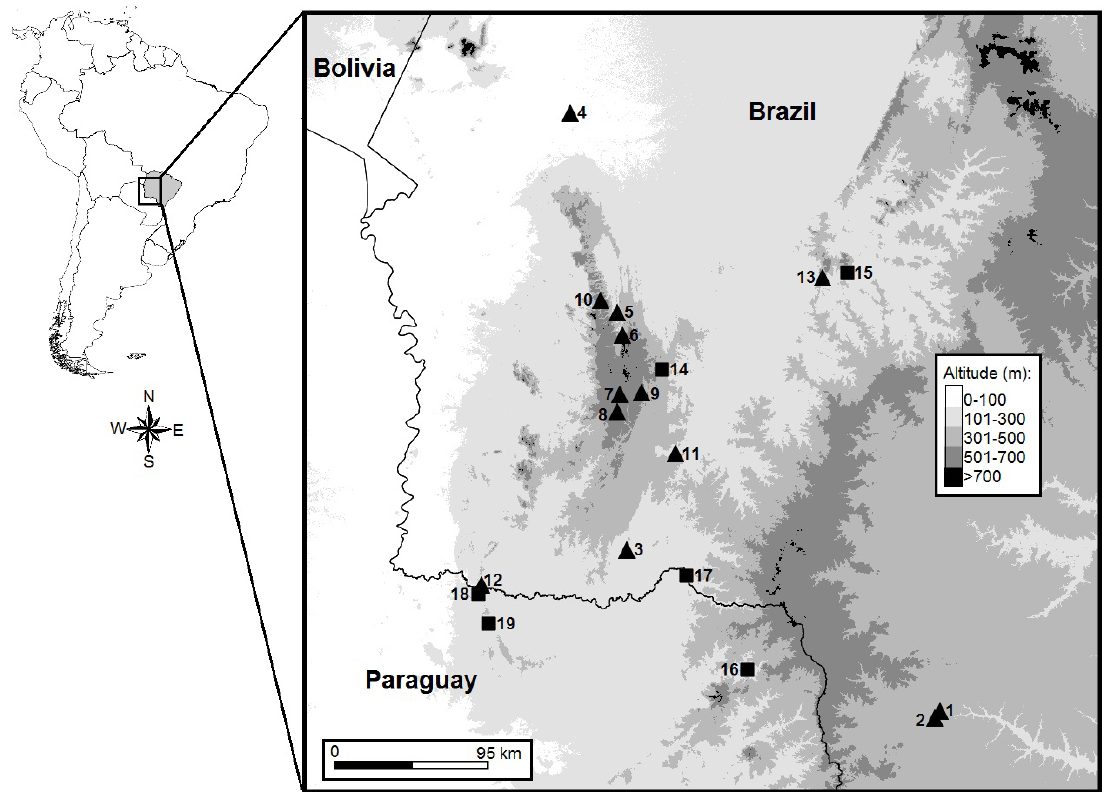
Rhinella scitula Geographic distribution map of . Triangles are records from the present work, and squares are records from the literature. The localities are: 1 and 2) Campanário farm; 3) Xerez farm; 4) UFMS Pantanal research station; 5) Rancho Branco farm; 6) Remanso farm; 7) Laudejá farm; 8) Harmonia farm; 9) Taquaral river; 10) Sol de Maio farm; 11) Cabeceira do Prata farm; 12) Parque Natural Municipal Cachoeiras do Apa; 13) Morcego stream, Camisão district; 14) Type locality, Estância Mimosa Ecotourism; 15) Vale das Bruxas; 16) National Park Cerro Corá, department of Amambay, Paraguay; 17) Bella Vista, department of Amabay, Paraguay; 18) National Park Serrania de San Luis; 19) Estância San Luis.